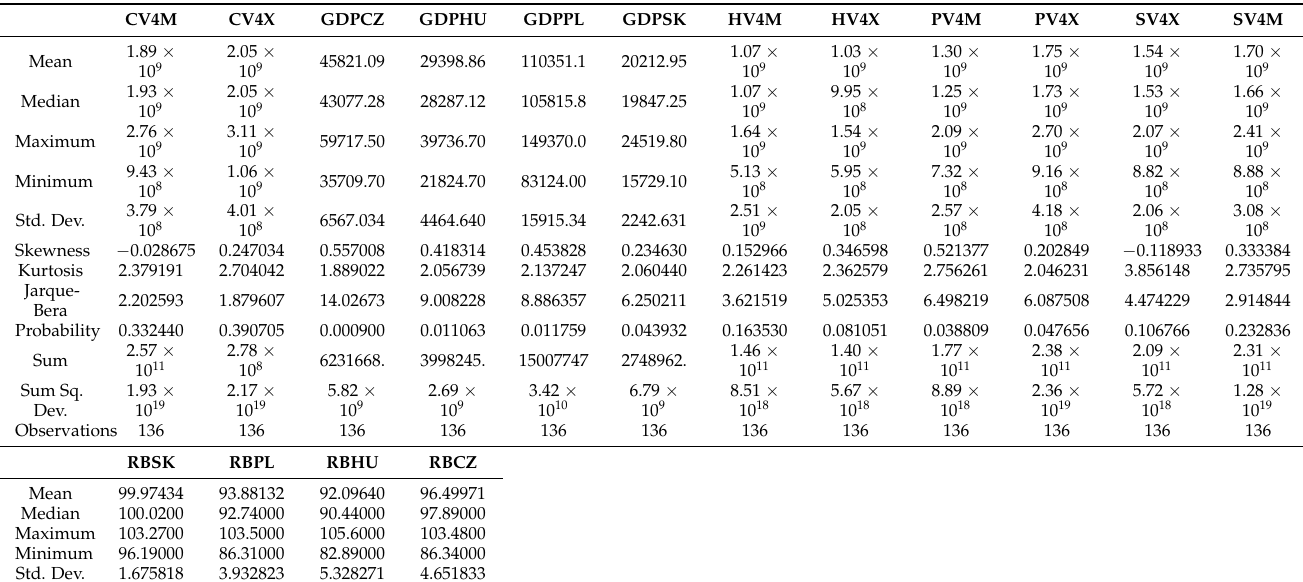
Table A1. Descriptive Statistics of used